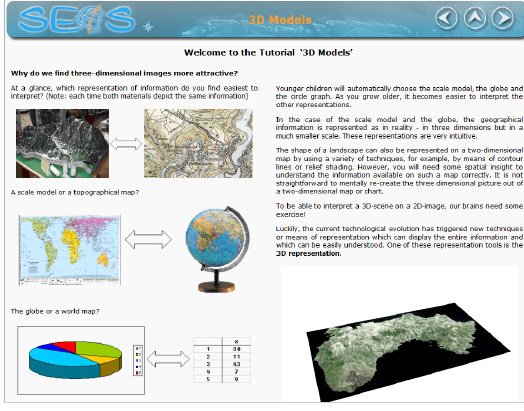
Figure 5: SEOS – Tutorial on 3D models http://lms.seos-project.eu/learning_modules#2